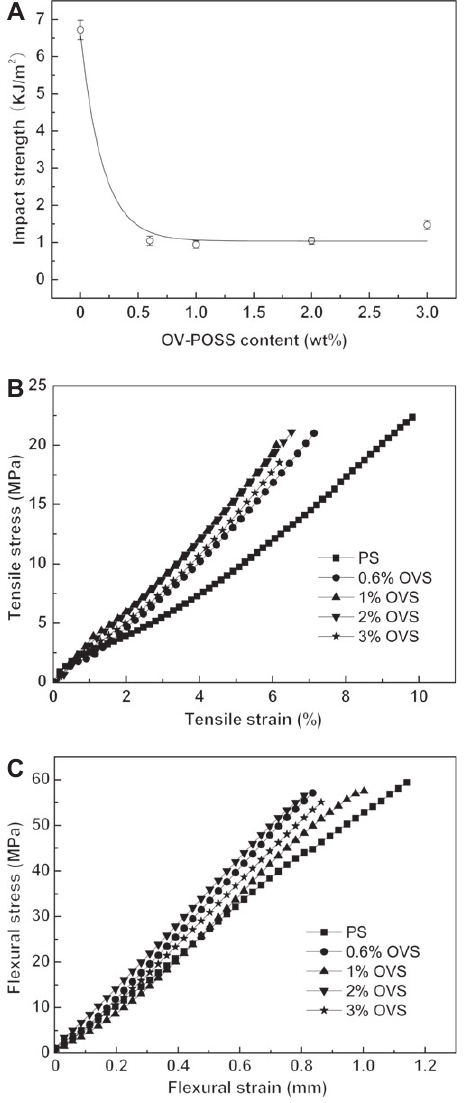
Figure 1 Impact strengths (A) of PS-OV-POSS composites with various OV-POSS contents and the tensile (B) and flexural (C) stress-strain curves.